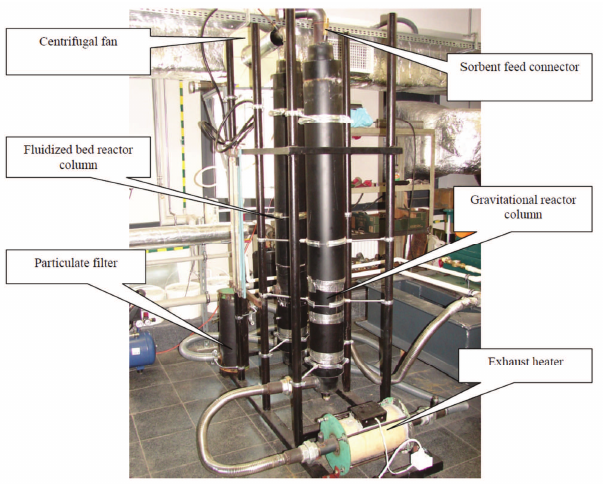
Fig. 2. An overview of the exhaust gas desulfurization station using the dry